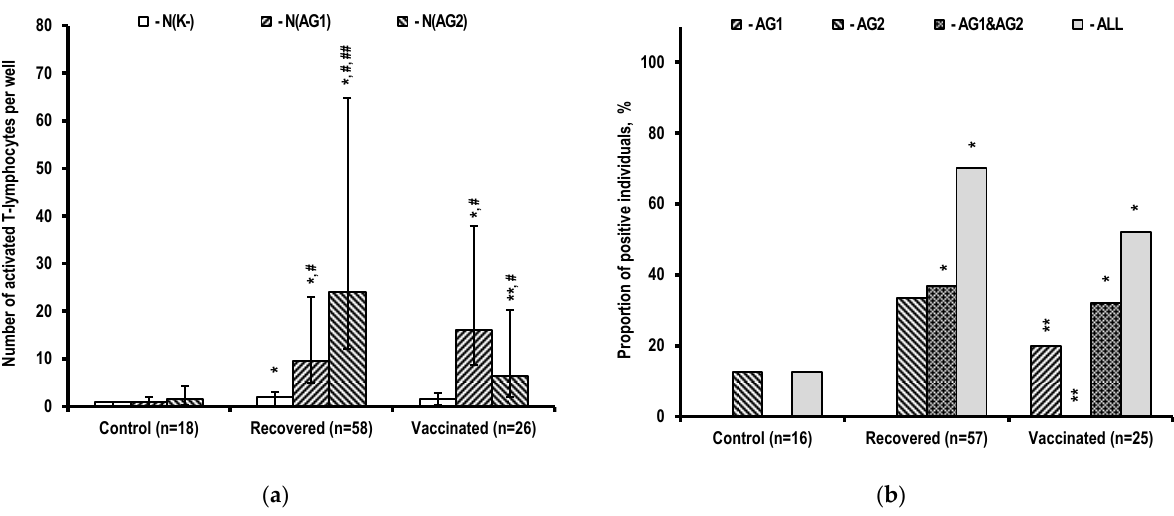
Figure 1. Activated T ‐ cell count in PBMC samples. ( a ) Number of T ‐ cells producing IFN ‐γ in wells without stimulation (N(K − )) and with specific stimulation using various sets of antigens (N(AG1), N(AG2)). The data are presented as Me (Q1; Q3). ( b ) Proportions of individuals testing positive for a T ‐ cell immune response to SARS ‐ CoV ‐ 2 virus antigens. AG1, AG2: Positive response to antigens of only one set. AG1&AG2: Positive response to antigens of both sets simultaneously. * p < 0.01 when compared to controls using the same parameter. ** p < 0.01 when compared to recovered individuals using the same parameter. # p < 0.01 when compared to non ‐ stimulated PBMCs within a group. ## p < 0.01 when comparing PBMCs stimulated with various sets of antigens within a group.